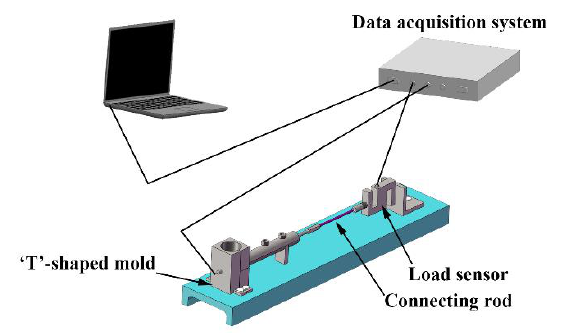
Figure 1. T-shaped hot tearing acquisition device.